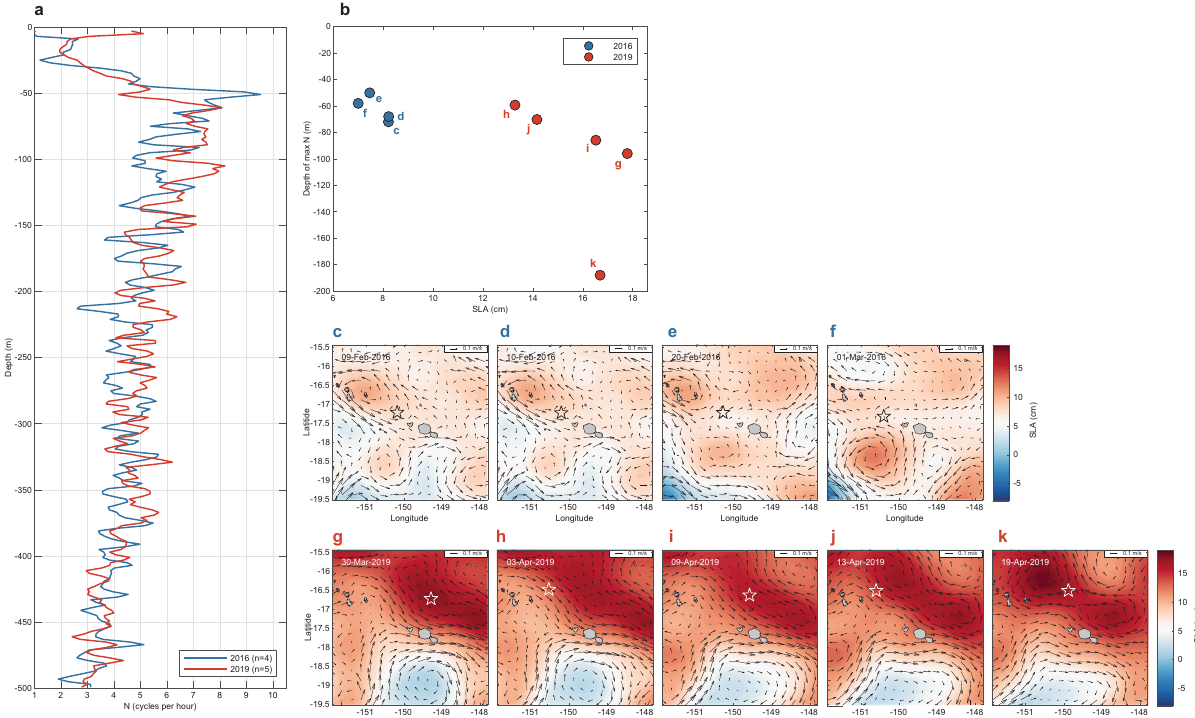
Fig. 8 | Propagation of warm-core eddies north of Moorea reduced strati fi ca- tion and increased mixed-layer depths during the 2019 marine heatwave (MHW). Vertical pro fi les of the buoyancy frequency (N, cycles per hour) are shown a averagedover four and fi veArgo pro fi les(2m depth bins)forearly2016 (blue line) and 2019 (red line), respectively, suggesting a shallower and more pronounced strati fi cation (N peak) during 2016. b Elevated sea level anomalies